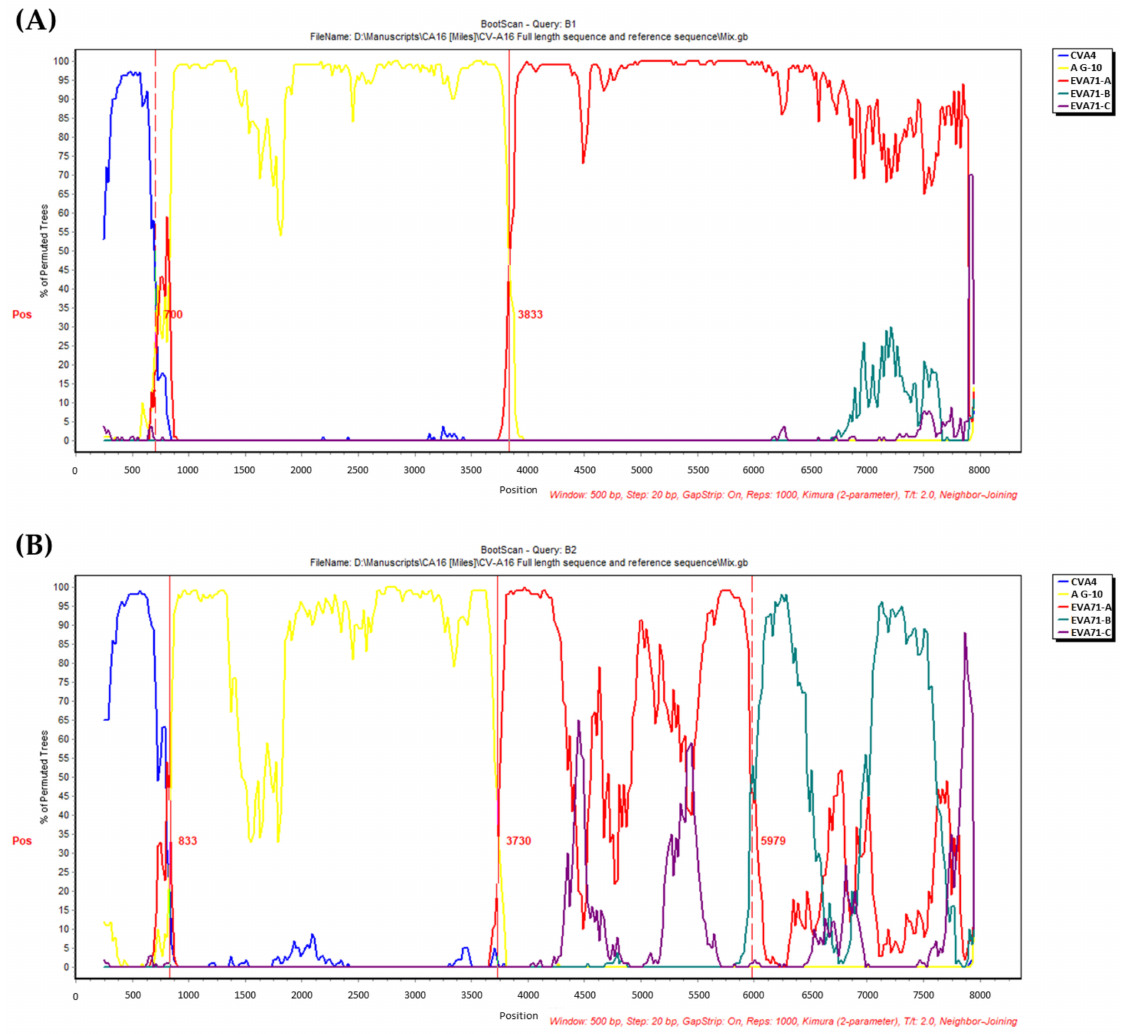
Figure 4. Bootscan analysis of CVA16 genotype B1 ( A ) and genotype B2 ( B ) compared with EV − A (CVA4/High Point, EVA71 − A/BrCr, EVA71 − B, EVA71 − C, and CVA16/G10). The CVA16